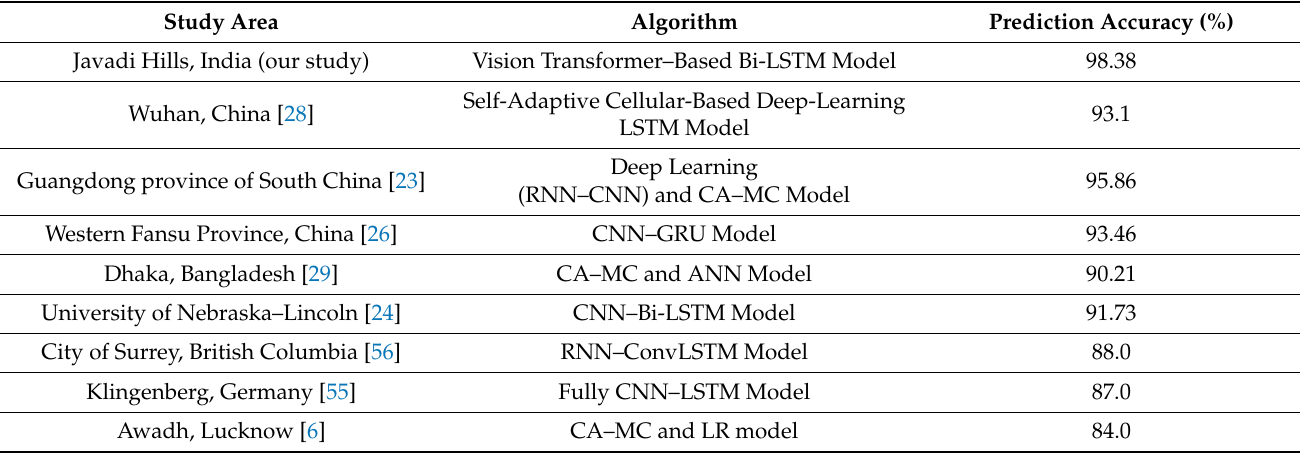
Table 14. Comparative analysis of LU/LC prediction models for different study